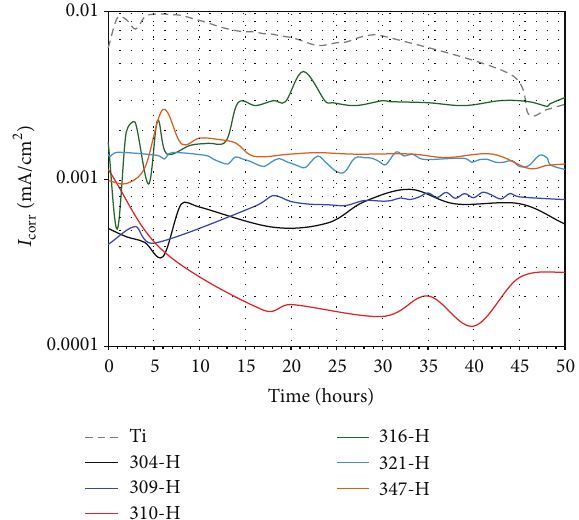
Figure 11: Change of 𝐼 wash solution at 37 ∘